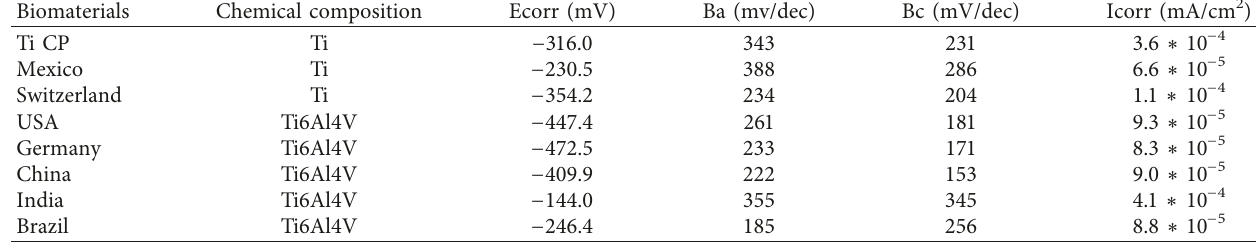
Table 1: Electrochemical parameters from the polarization curves of the different biomaterials evaluated. Biomaterials